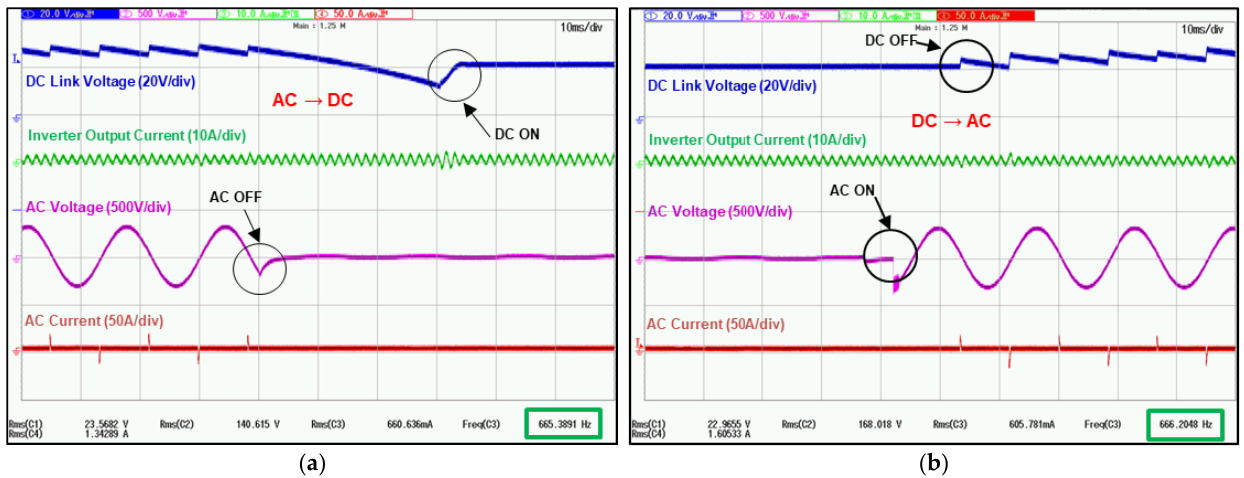
Figure 14. The waveforms of power changing: ( a ) AC → DC power changing condition; ( b ) DC → AC power changing